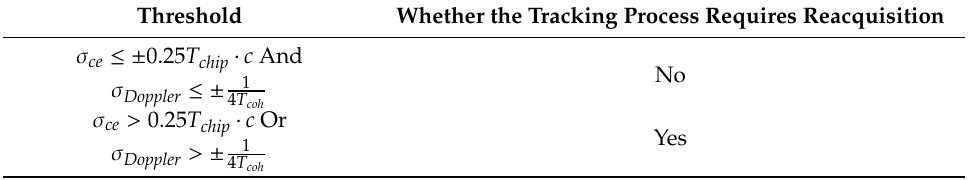
Table 3. The relationship between the correction errors and whether the tracking process requires reacquisition.